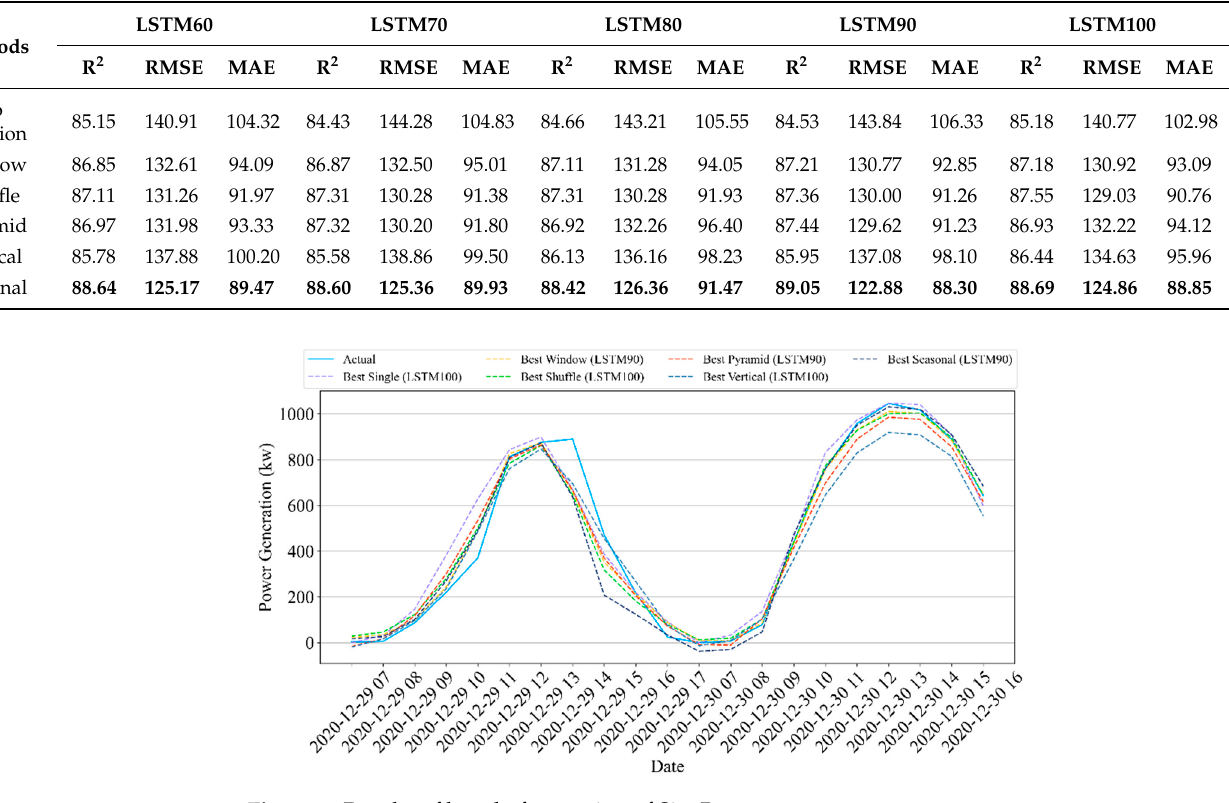
Figure 8. Results of hourly forecasting of Site B.